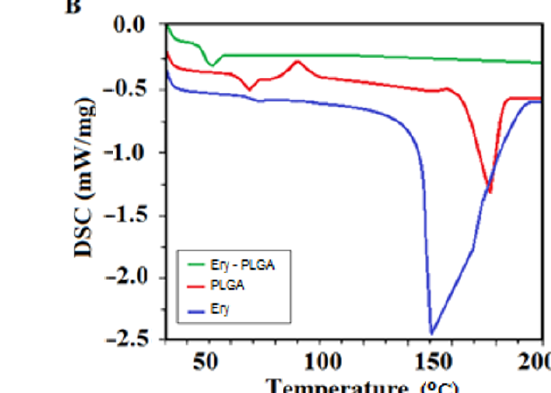
Figure 9. SEM images of ( A ) Ery ‐ PLA and ( B ) Ery ‐ PLGA.